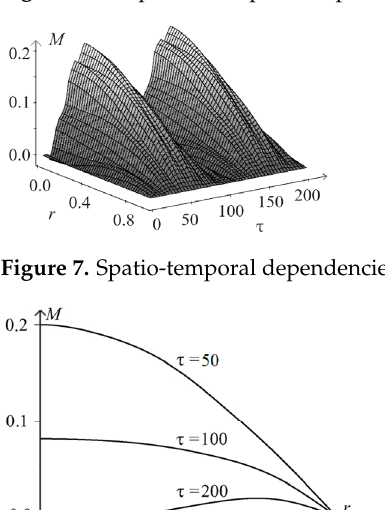
Figure 6. Temporal and spatial dependencies for deflection